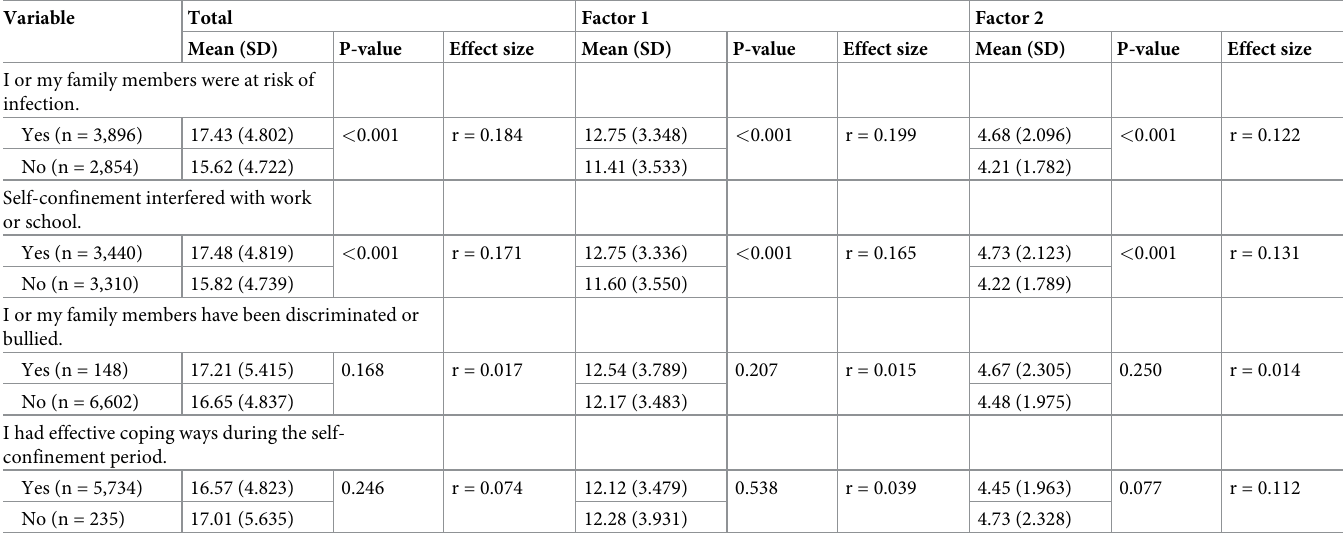
Table 6. Association between FCV-19S score and experiences during COVID-19